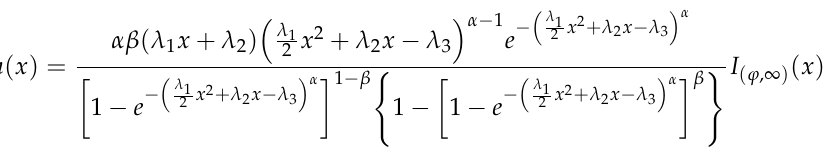
> λ 2 + 2 λ 1 1 λ 3 2